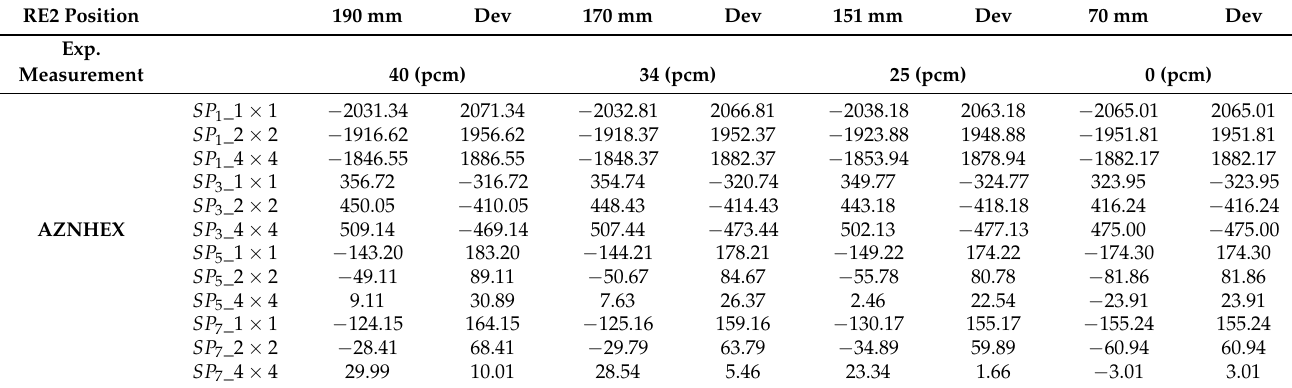
Table 9. Reactivity values and deviation in pcm from AZNHEX calculations with radial and axial refinements and experimental data.